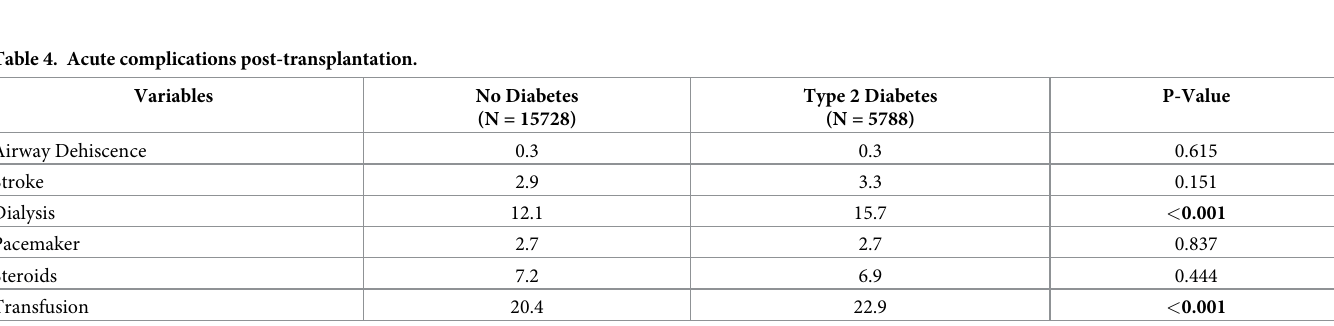
Table 4. Acute complications